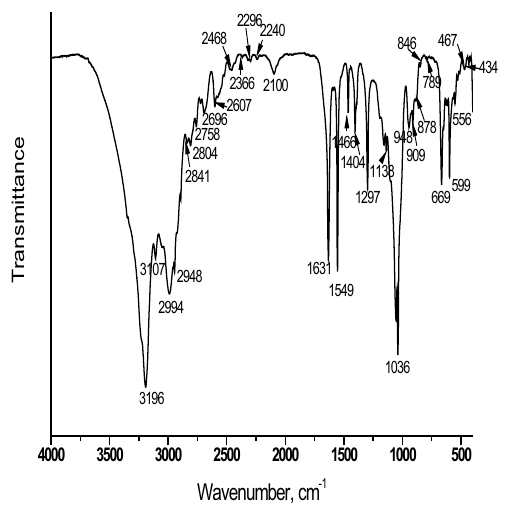
Figure 10. FTIR of the G/S 25:75 wt.% after immersion in SBF for 3 days Table 2. IR vibration modes and their assignments observed for the G/S hybrids immersed in 1.5 SBF for 3 days Vibration